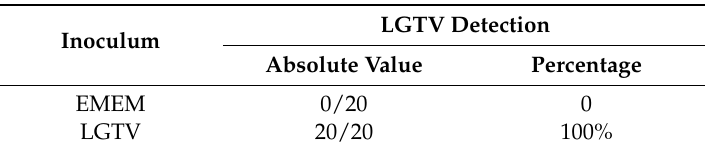
Table 2. Detection of Langat virus RNA from ticks injected with LGTV and Eagle’s Minimum Essential Medium via anal pore microinjection using reverse transcription